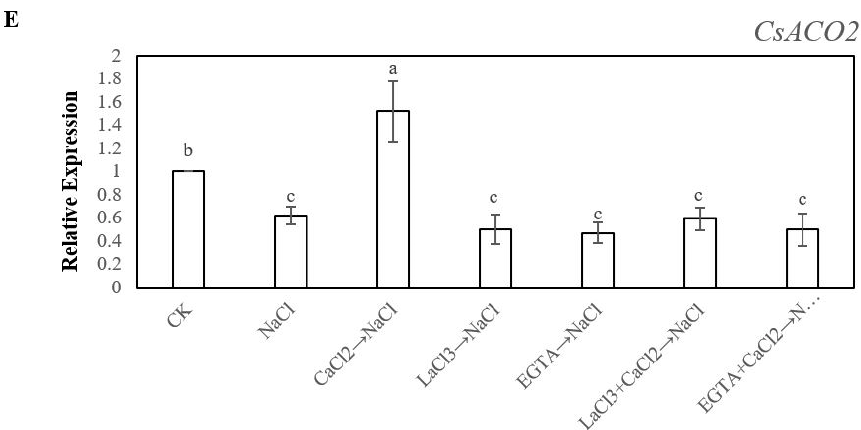
Figure 6. Effects of Ca 2+ on the Expression Levels of ACS gene CsACS1 ( A ), CsACS2 ( B ), CsACS3 ( C ), and ACO gene CsACO1 ( D ), CsACO2 ( E ) in cucumber explant under salt stress at 48 h. The primary roots were removed from hypocotyl of 5-day-old seedlings. Explants were incubated for five days with distilled water as control, meanwhile the explants were incubated with 13 mM NaCl after being treated with distilled water or 10 μ M CaCl 2 , 500 μ M LaCl 3 , 100 μ M EGTA, 500 μ M LaCl 3 + 10 μ M CaCl 2 , and 100 μ M EGTA + 10 μ M CaCl 2 , respectively. The values (means ± SE) are the average of three independent experiments. Bars with different lowercase letters were significantly different by Duncan’s multiple range test ( P < 0.05).